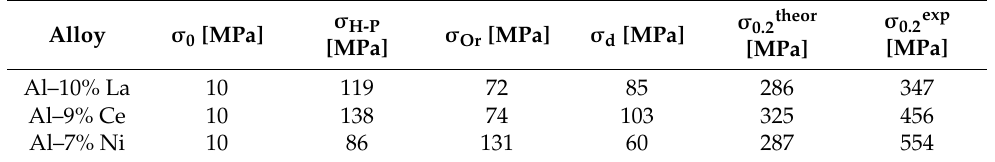
Table 4. Estimated contribution of different strengthening mechanisms to the increase in the yield stress of eutectic aluminum alloys after